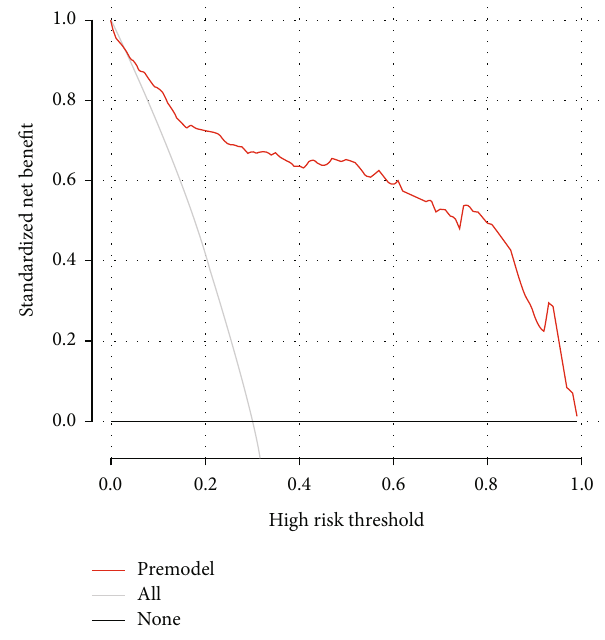
Figure 5: Decision curve of nomogram